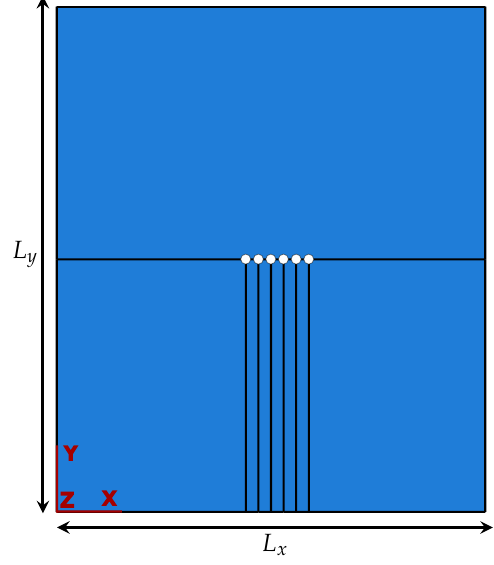
Figure A1. Abaqus model for transmission beamforming